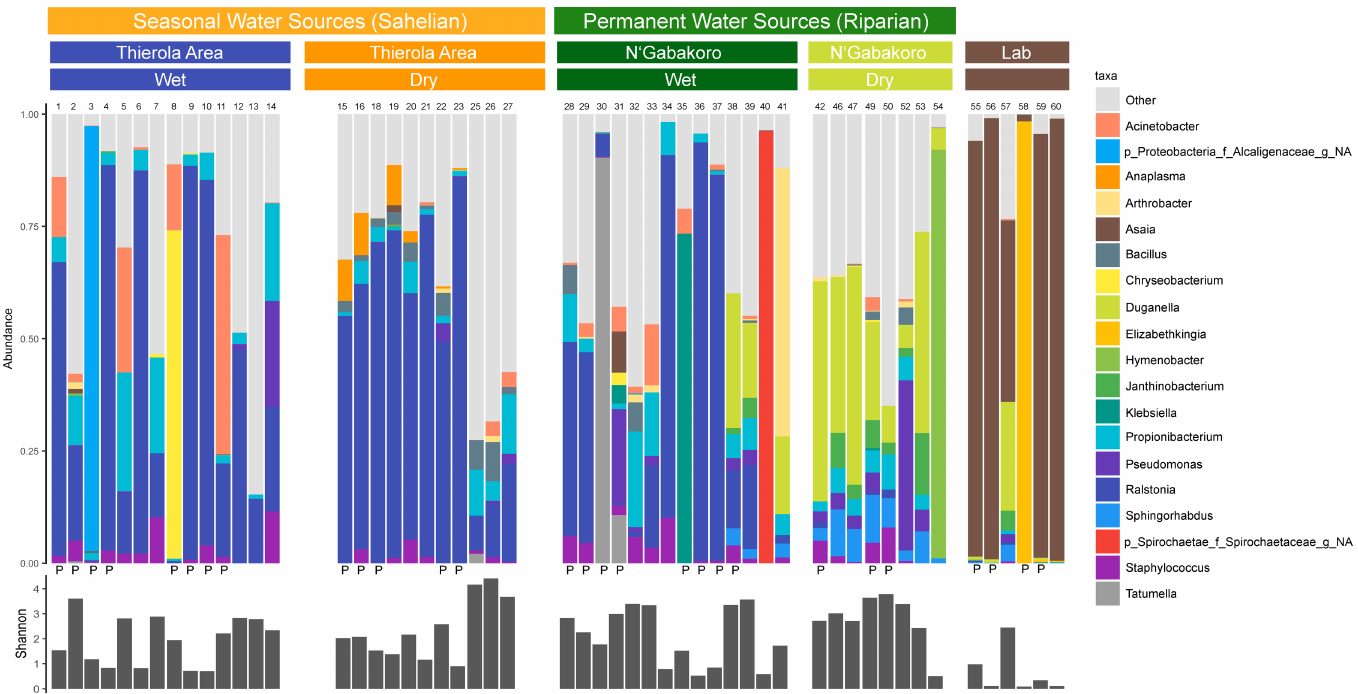
Fig 2. Stacked bar plot (top) and within-sample Shannon diversity (bottom) comparing the 19 most abundant agglomerated microbial genera between dry and wet seasons. All other taxa are grouped in the “other” category. Sample numbers and whether it is a pooled sample (“P”) are marked above and below bar plots, respectively. Only the top 19 genera are shown here for clarity in display and to be able to distinguish between groups, all analyses between groups were performed with all sequence variants or taxa.